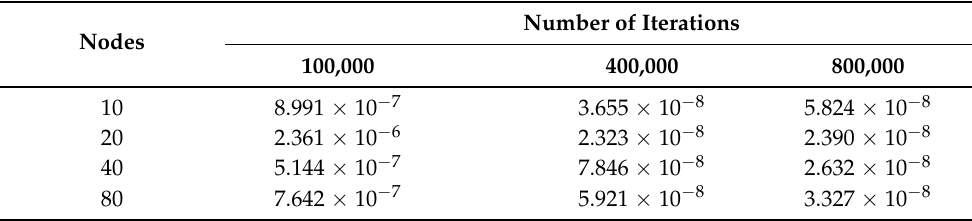
Table 4. Results of the mean square error analysing of varying number of iterations and number of nodes per layer in the simulations.